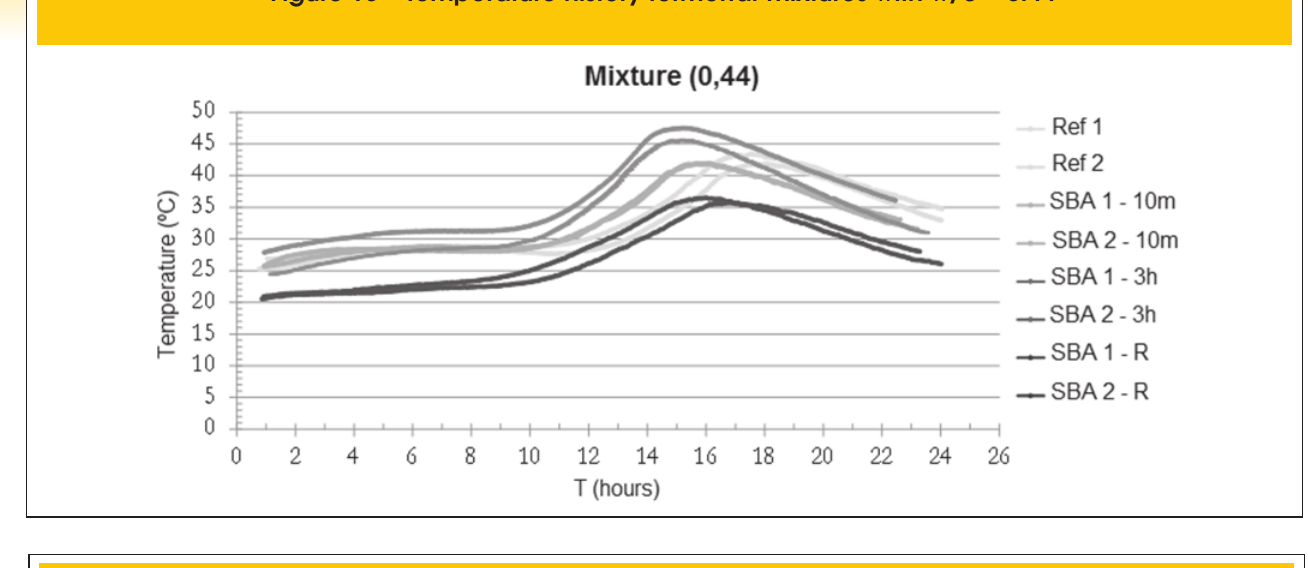
Figure 11 – Temperature history for mortar mixtures with w/c = 0.48